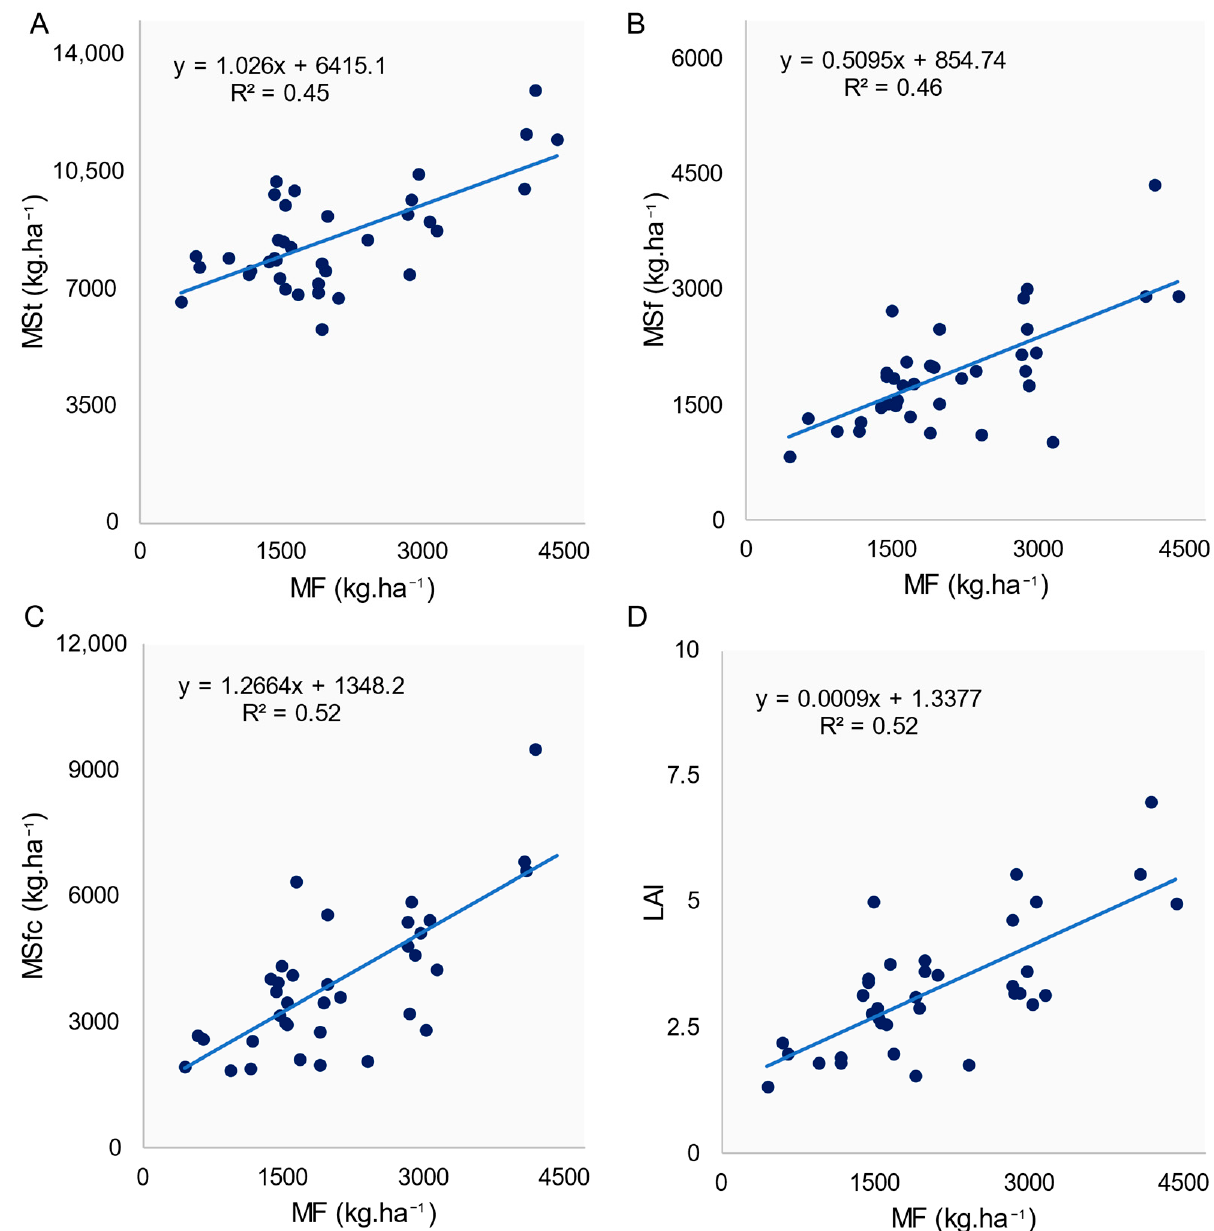
Figure 8. SAFER estimated fresh mass (MF) and of Piatã grass pasture variables linear regression in the INT system. ( A ) total dry mass (MSt); ( B ) dry mass of leaves (MSf); ( C ) leaf and stem dry mass (MSfc); ( D ) leaf area index (LAI).